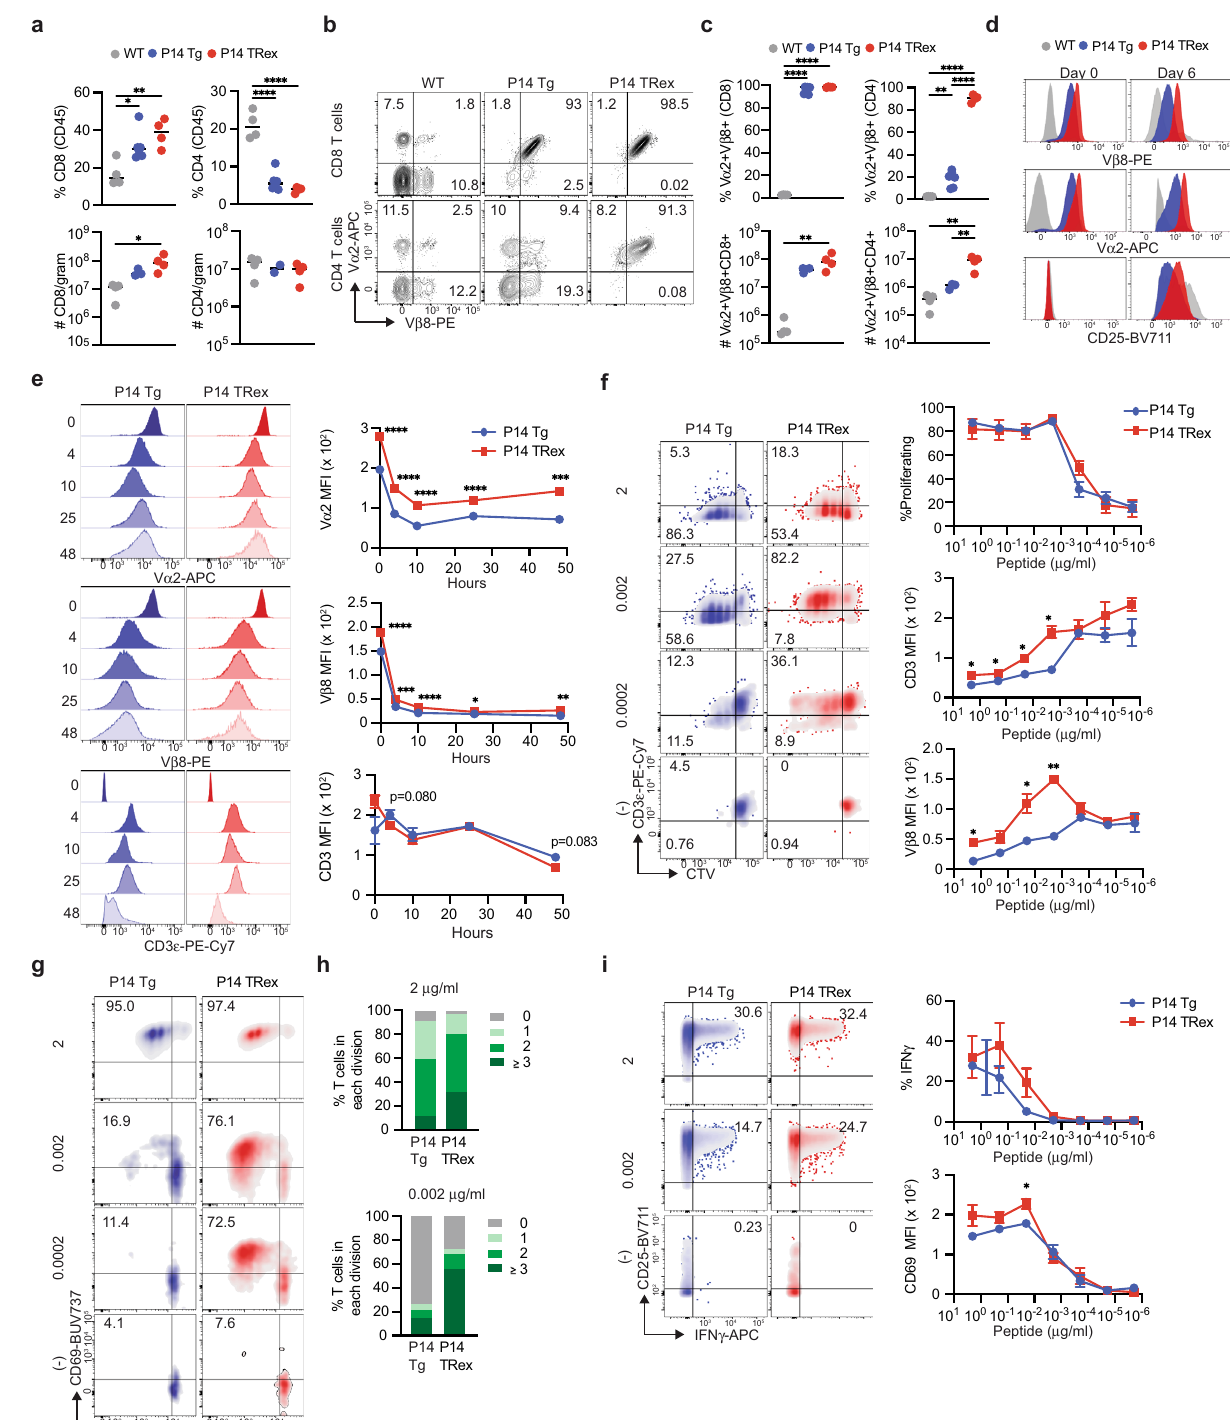
CCAATGTCCTCTGTCATGTTCT-3 ′ , with an amplicon length of 579bp; Msln KO forward, 5 ′ -AGGTGGGTTCAGTACCTTTG-3 ′ , and Msln KO reverse, 5 ′ -GATCAGCTCAGACTTGGGATAG-3 ′ , with an amplicon length of 698 bp. Ampli fi cation was run for 30 cycles at 95°C for 30s, 55 °C for 30 s, 74 °C for 1 min. To assess exogenous TCR integration into the Trac locus, we created a Trac junction PCR using the following gene-speci fi c PCR primers: wild type (WT) Forward, 5 ′ - CTCTGGTGTGAGTGCTATTC-3 ′ , 1045 and 7431 knock-in (KI) Forward, 5 ′ -CCTGTTCTGGTACGTGAGATAC-3 ′ , P14 KI Forward, 5 ′ -GTAGCTAT